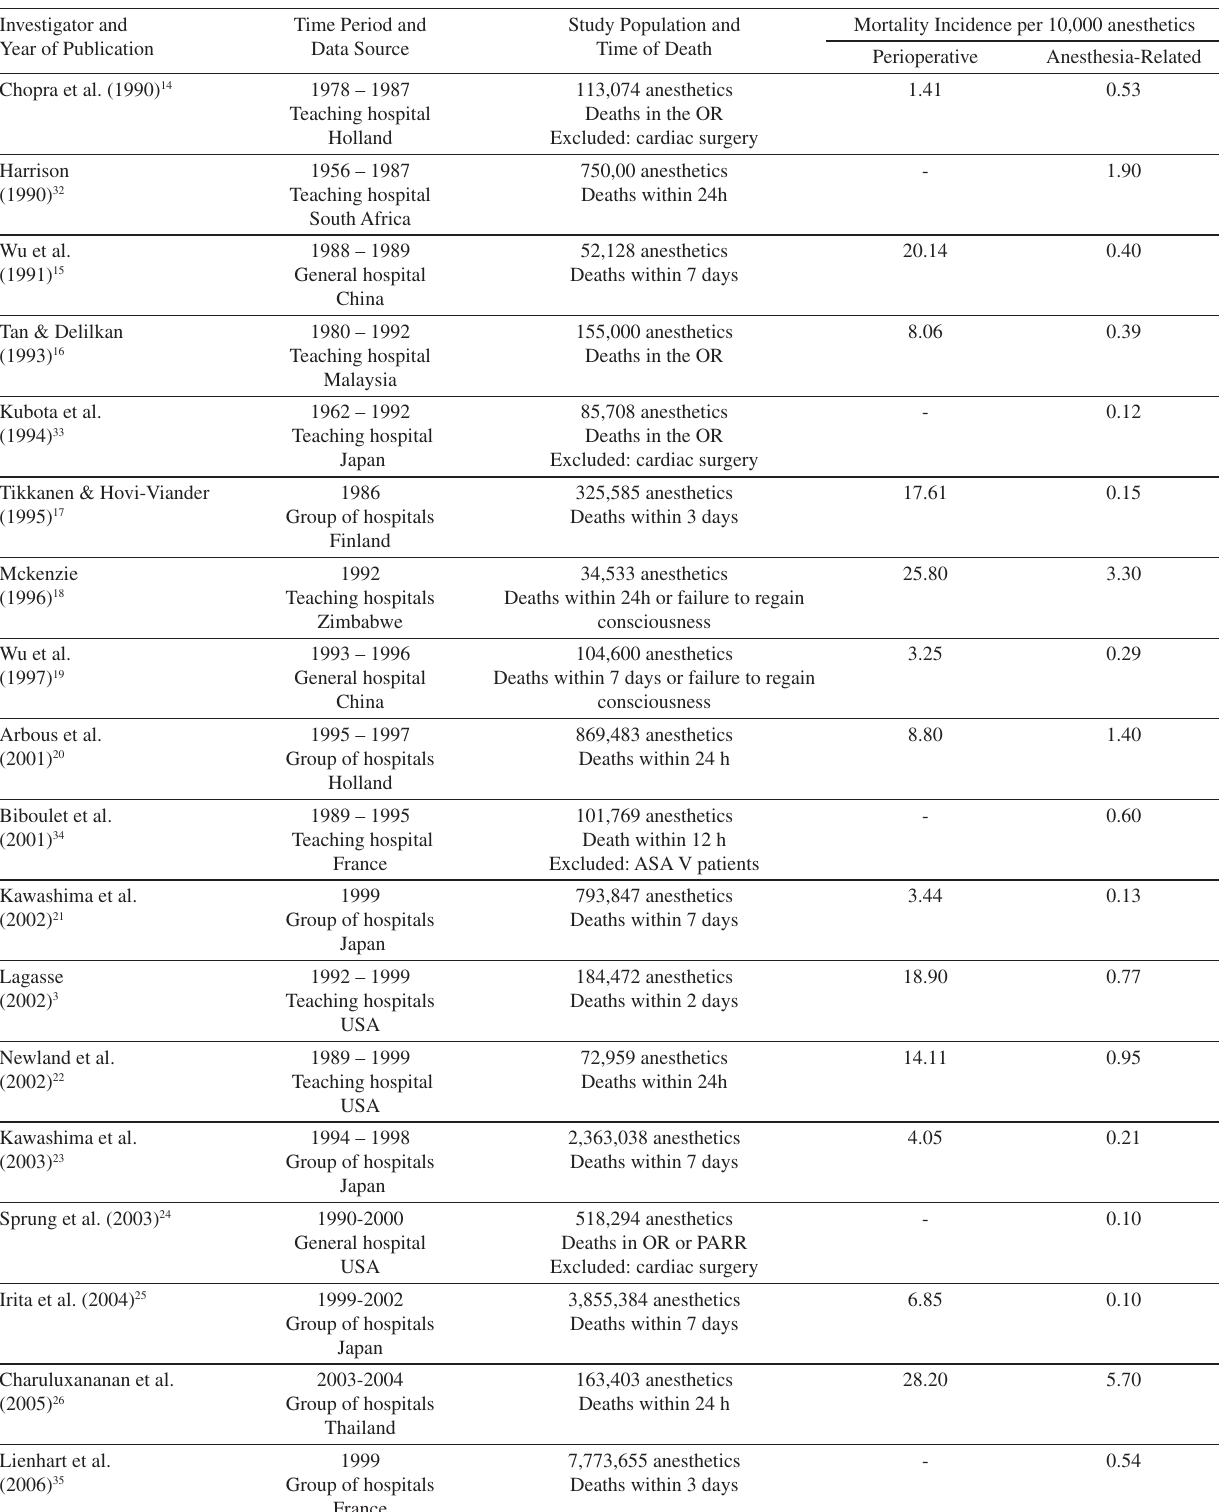
Table 2 - Mortality incidence in patients receiving anesthesia according to studies performed in different countries between 1990 and